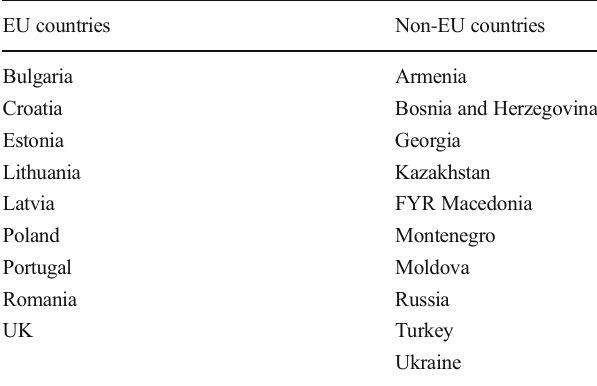
Participating countries for the Zagreb Workshop EU countries Non-EU